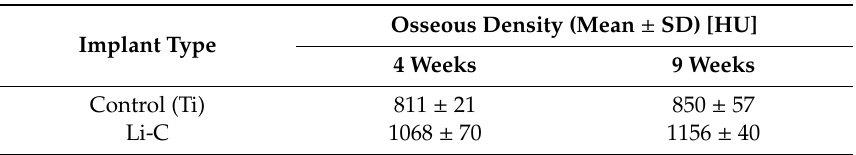
Figure 5. Lateral computed tomography images showing the positioning of the 3D metallic implants (right foot—implant functionalized with Li-C coating, left foot—control Ti implant), at 4 weeks after surgery. Table 1. Osseous density (mean ± standard deviation, SD) inferred at the implant–bone interface for control and functionalized (with Li-C coatings) 3D Ti implants.